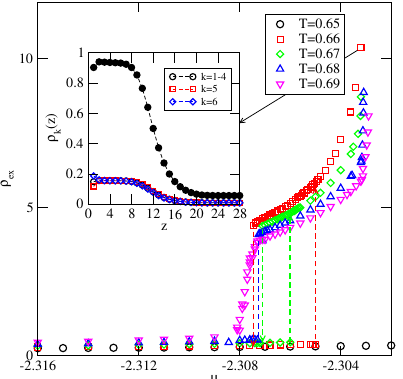
Figure 21. The main figure shows a series of adsorption isotherms for the system with u AB = − 1.0 and V o = − 0.5. The inset presents the local density profiles recorded at T = 0.66 and µ = − 2.3032. The filled circles mark the total local density, ρ ( z ) , while the open symbols correspond to ρ k ( z )